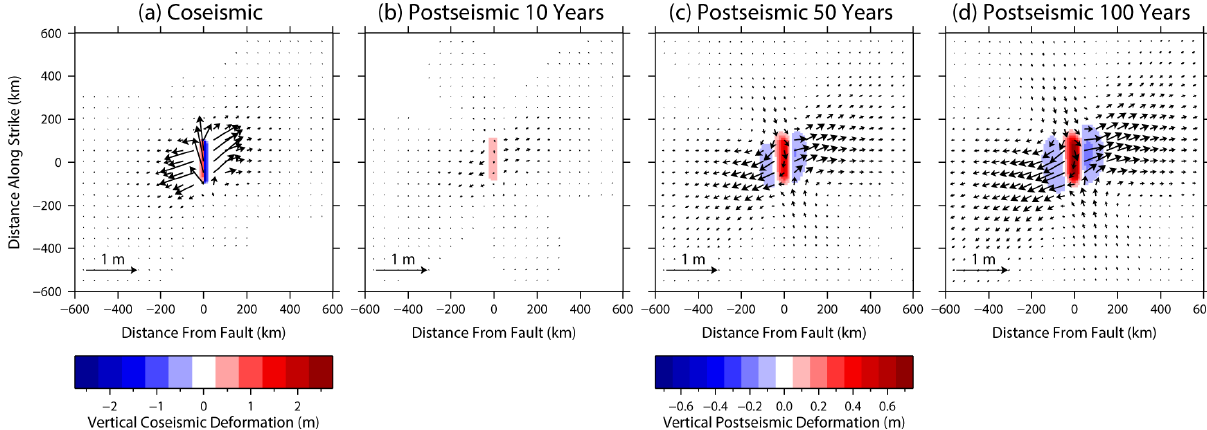
Figure B3. As for Fig. B1 but for a 45 ◦ dipping fault. Note the different colour scales for coseismic and post-seismic displacement.